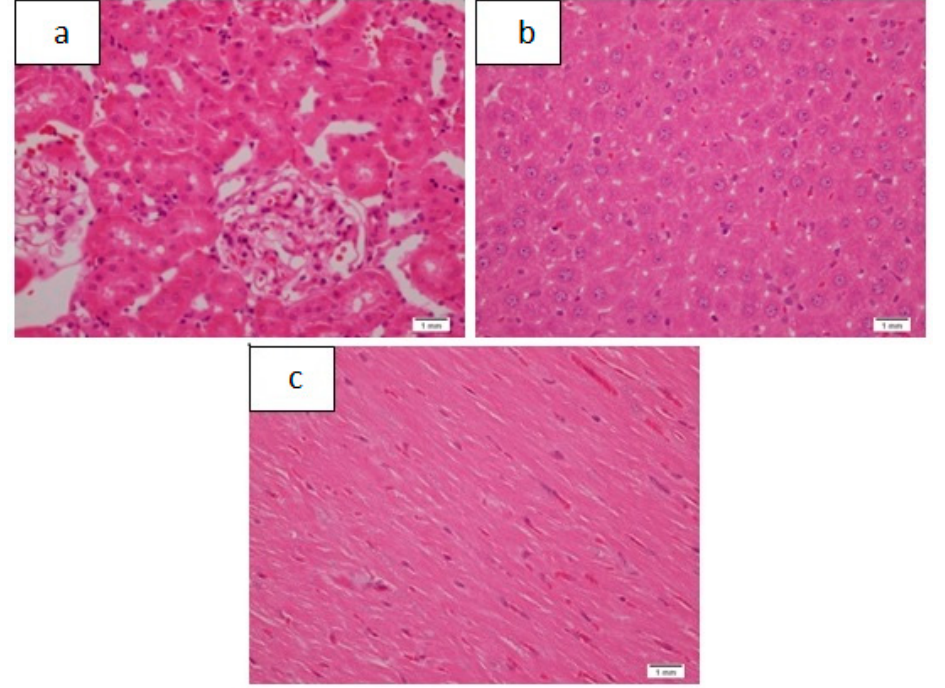
Figure 7. Unremarkable renal ( a ), hepatic ( b ), and cardiac ( c ) tissue, as seen in controls of sub-acute toxicity, H&E, and ×20.